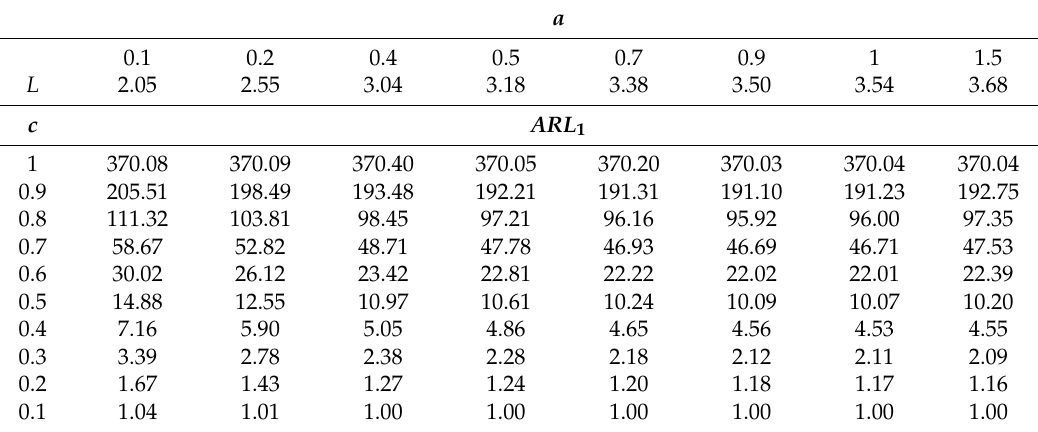
Table 2. The values of ARLs when r 0 = 370, β = 0.5, and µ 0 = 100.